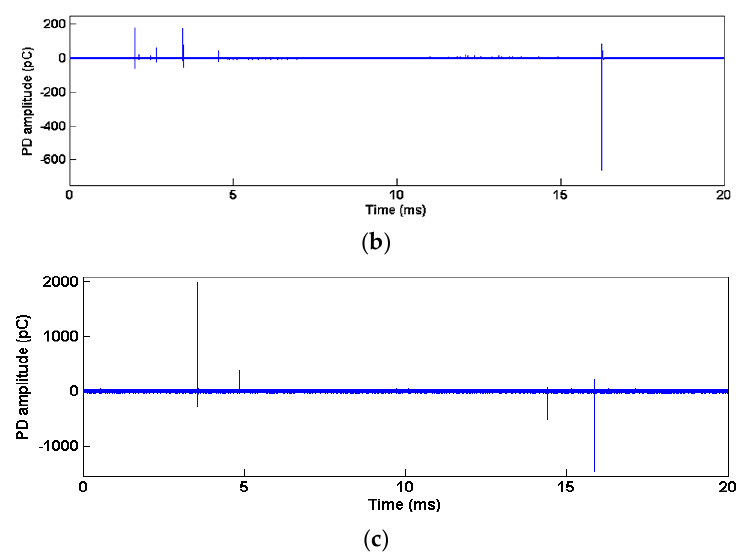
Figure 6. PD pulses in one primitive cycle of three models. ( a ) Needle-plate; ( b ) Surface discharge; ( c ) Air gap.